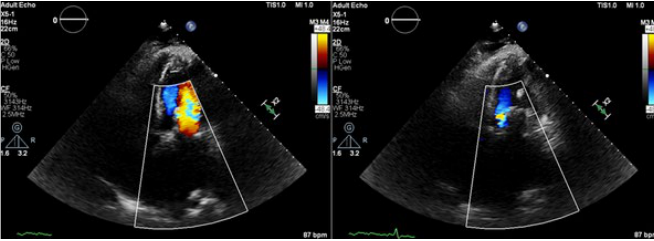
Figure 1 Neo-LVOT simulation after Tendyne TM prosthesis implantation us- ing ECG triggered computer